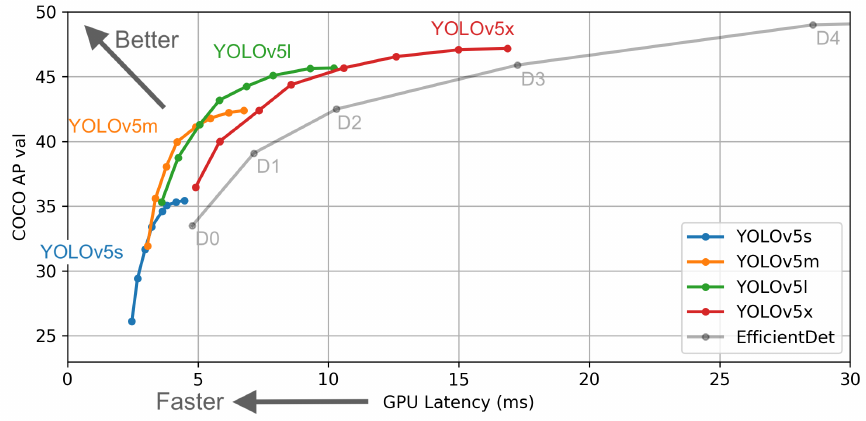
Figure 4. Performance comparison between YOLOv5 and EfficientDet [25]. COCO AP Val denotes the mAP metric measured on the COCO val2017 dataset over various inference sizes from 256 to 1536. The GPU speed measures the average inference time per image on the COCO val2017 dataset. It shows that the YOLOv5 family is much faster than EfficientDet with a good